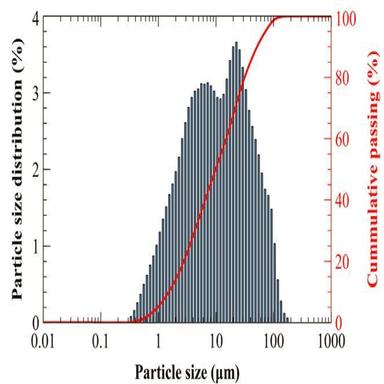
Particle size distribution of the ceramic powder.